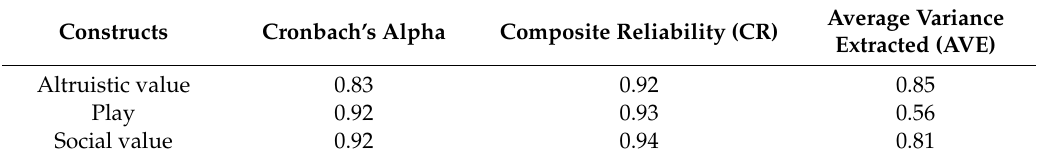
Table 3. Cronbach’s alpha, composite reliability, and average variance extracted (AVE).